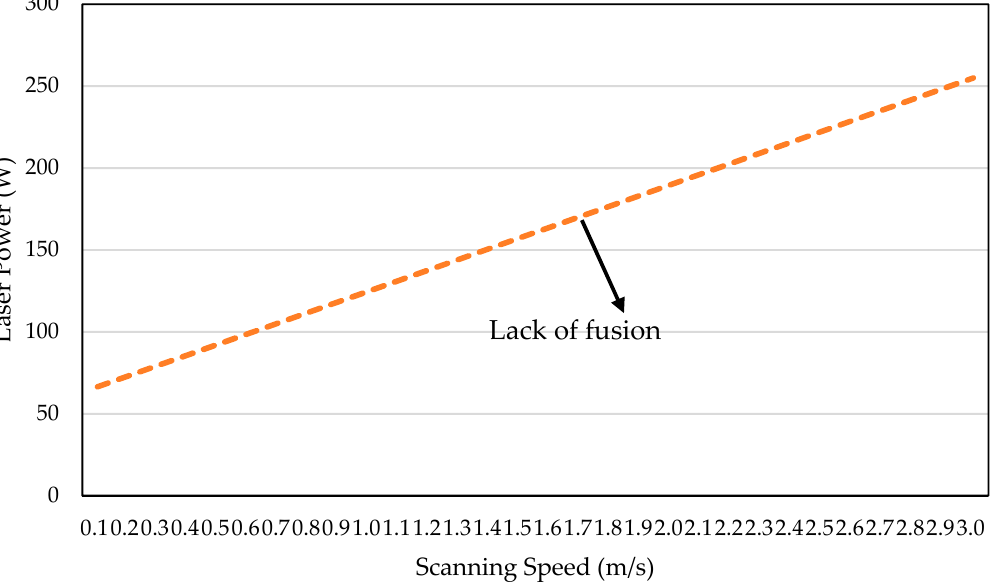
Figure 7. The calculation of Equation (15) for In718 (H is 100 μ m and L is 40 μ m).